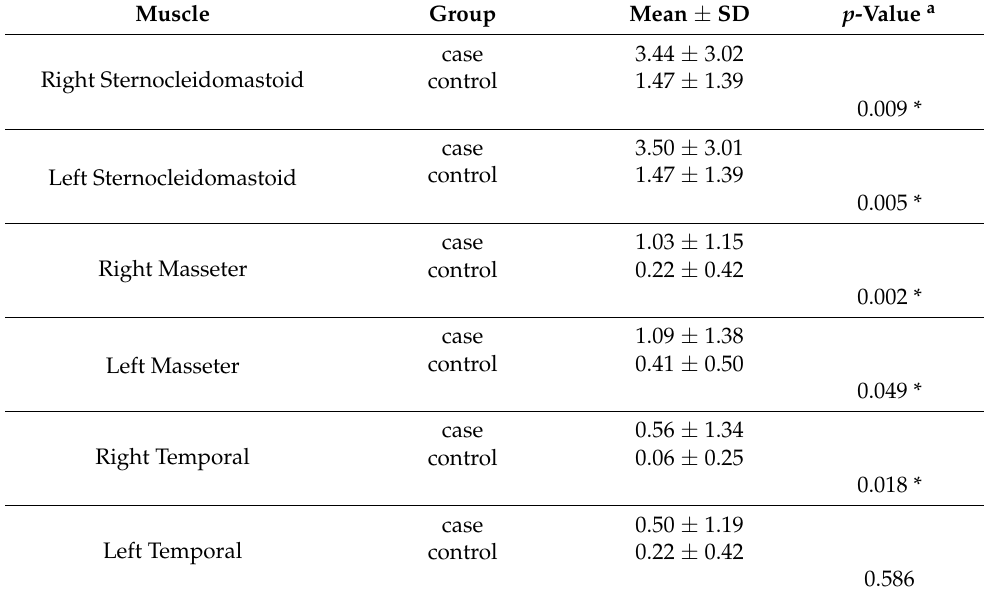
Table 2. Head and neck muscle palpation analysis (Mann–Whitney U test). Mean values of VAS (Visual Analogue Scale) resulting from palpation analysis on masseter, temporal and sternocleido- mastoid muscles on both